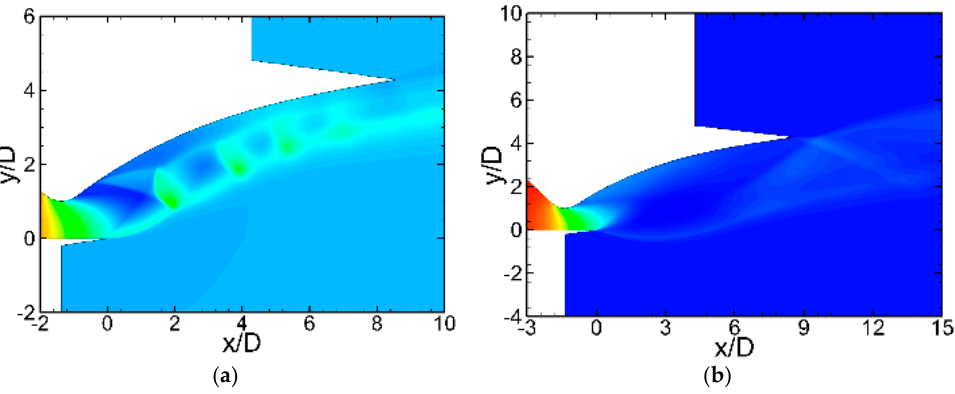
Figure 4. Typical iso-density contours of dry airflow. ( a ) p 0 = 7 bar, T 0 = 436 K; and ( b ) p 0 = 32 bar, T 0 = 510 K.